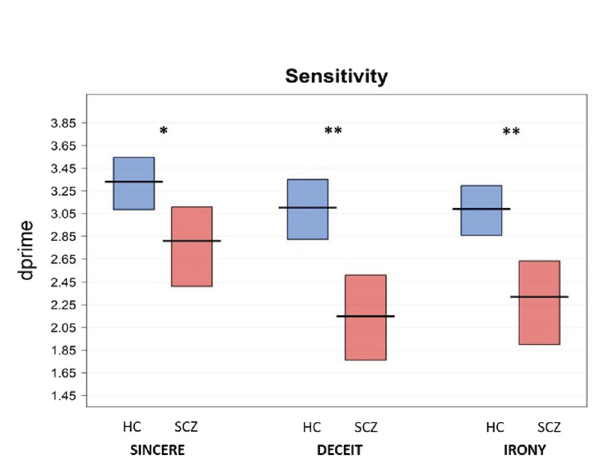
Fig. 1 Sensitivity (d-prime) values for sincere, deceitful, and ironic communicative acts in the SCZ and HC groups. Note: The horizontal line corresponds to the mean of the different groups (SCZ = schizophrenia, HC = healthy controls) for the different communicative acts (Sincere: SCZ = 2.81 (sd = 0.81), HC = 3.33 (0.56), Cohen ’ s d : 0.75 [0.16, 1.34]; Deceit: SCZ = 2.15 (0.88), Cohen ’ s d : 1.24 [0.62, 1.86]; HC = 3.01 (0.63); Irony: SCZ = 2.32 (0.87), HC = 3.09 (0.48), Cohen ’ s d : 1.10 [0.48, 1.70]), and the rectangle represents the Bayesian highest density interval. ** p < 0.01 *, p <